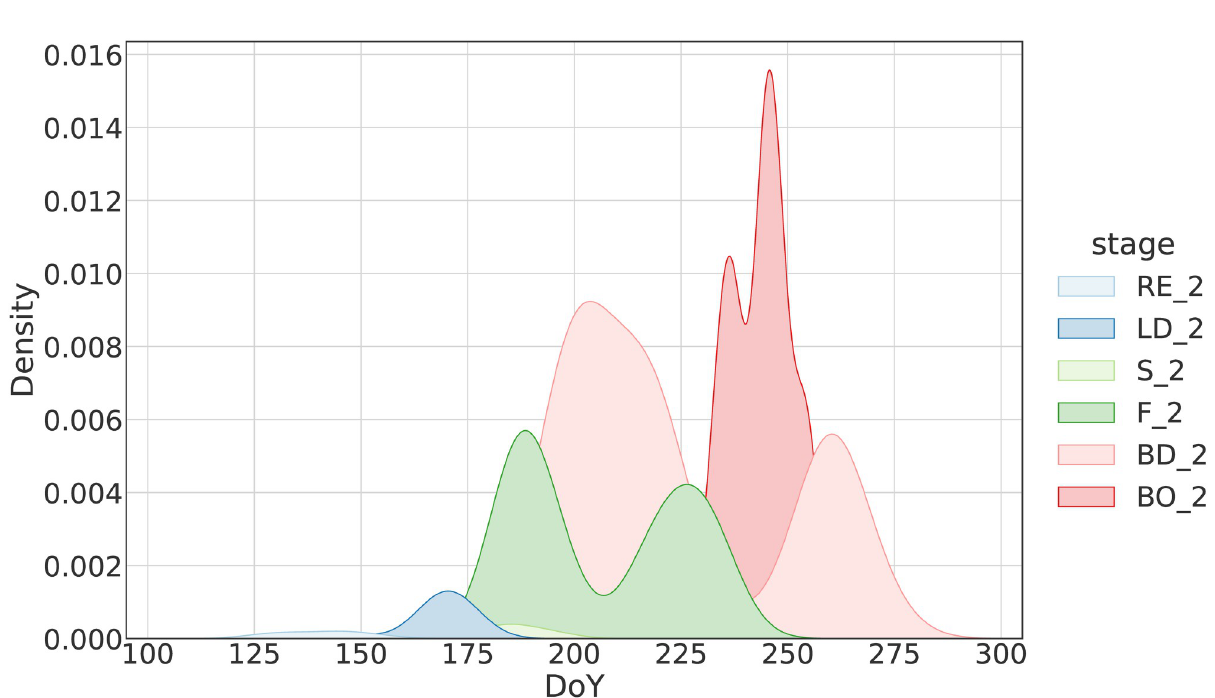
Fig 4. Distribution of DoY for which the inspector observed the phenological stages as secondary.